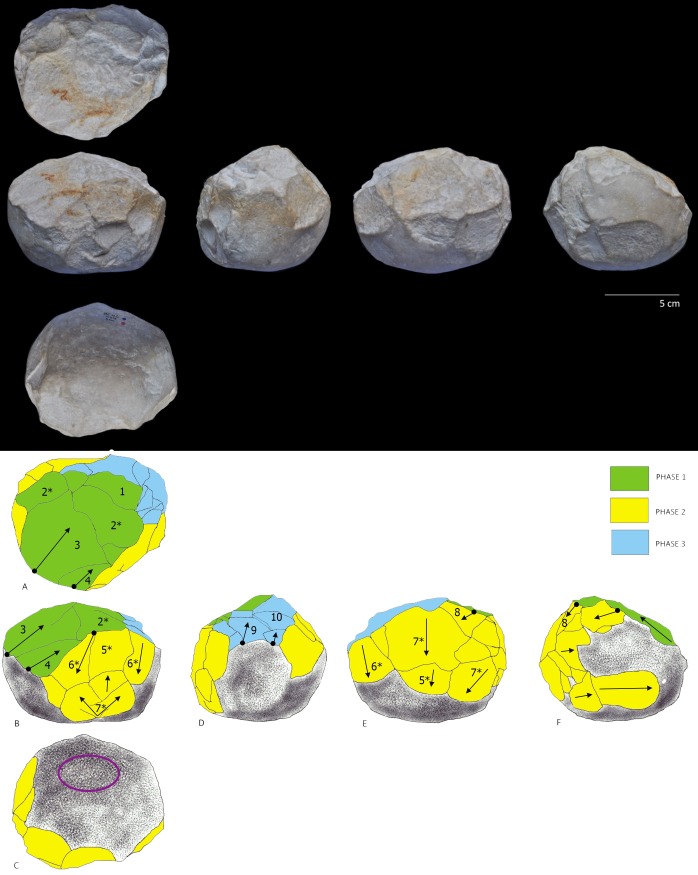
Photo and diacritical drawing of Tool D.Phase 1 (green) creation of a percussion platform (Profile A). Phase 2, (yellow) Platform negatives transected orthogonally, as the piece was peripherally knapped (Profiles B and E). Phase 3 (blue): Series of removals from a cortical platform (Profile D), cutting the structure transversely (Phase 2) and frontally (Phase 1). The use of the bipolar-on-anvil technique is observed (in particular on Profile B) (see negative 5 * and 6 * in contrast to negative 7 *), with some negatives probably resulting from anvil repercussion (ie. negative 7*). Traces of percussion (Fr. piquetage) are observed on the cortical surface (Profile C—circle).